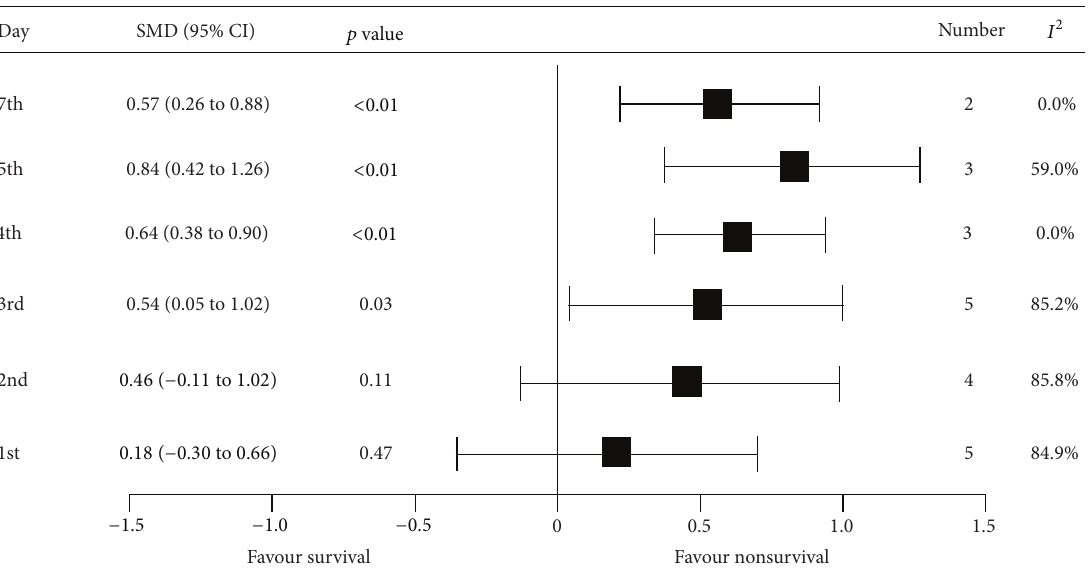
Figure 3: The summary of pooled mean differences of mean platelet volume on the observed day after admission between nonsurvivors and